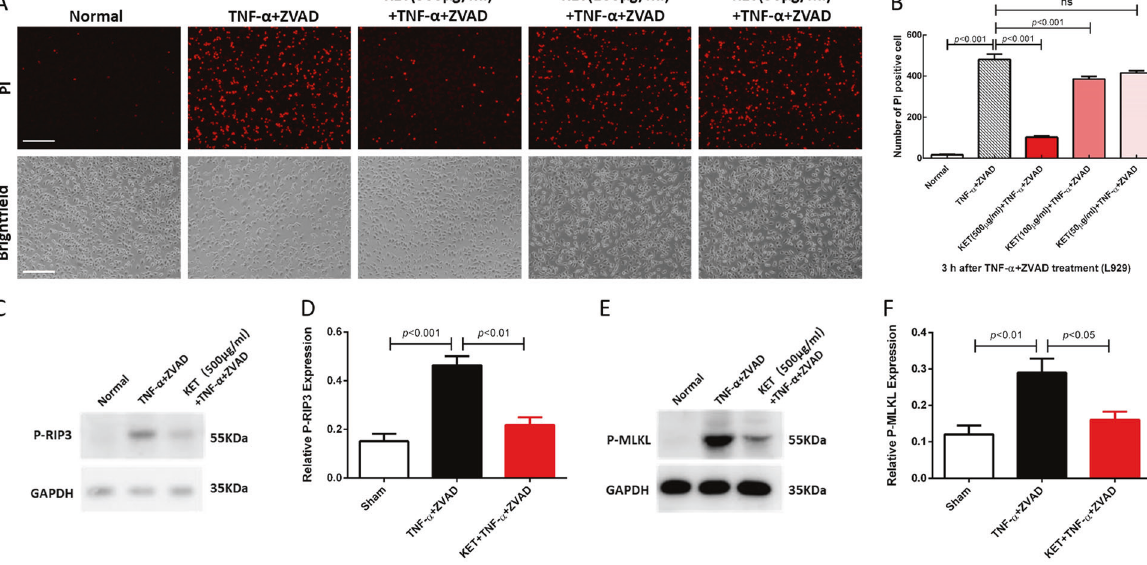
Fig. 6 The effect of ketamine on TNF-induced necroptosis in L929 cells. L929 cells were treated with nothing (Normal group), TNF- α + ZVAD, or TNF- α + ZVAD plus different doses of ketamine as indicated for 3 h. A , B The cells were stained with PI and analyzed by immuno fl uorescence staining and bright fi eld microscopy. PI-positive cells represent dead cells and were counted in three independent experiments. C – F Immunoblot analysis of p-RIP3, p-MLKL, and GAPDH in L929 cells treated with nothing (Normal group), TNF- α + ZVAD, or TNF- α + ZVAD plus ketamine for 3 h. Quantitative data are shown as the mean values of three independent experiments and the error bars are the mean ± SEM., ns no signi fi cant